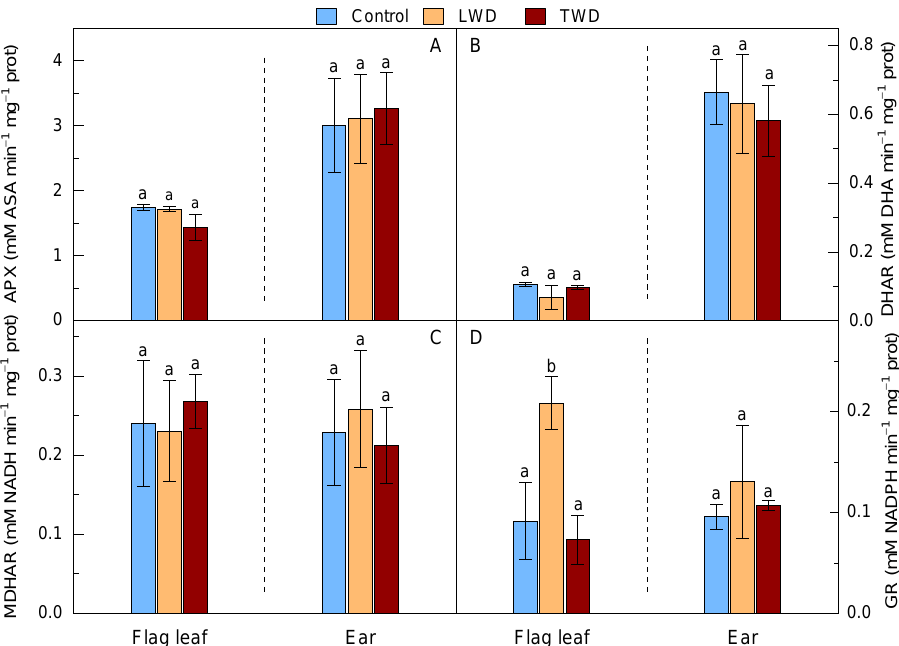
Figure 6. Effect of two water deficit treatments under combined elevated CO 2 and high temperature on ascorbate peroxidase (APX) (Panel A ), dehydroascorbate reductase (DHAR) (Panel B ), monodehydroascorbate reductase (MDHAR) (Panel C ) and glutathione reductase (GR) (Panel D ) activities in flag leaf and ear of potted wheat. Legend is as described in Figure 2. Bars represent mean values ± SD. Different letters above the bars (a and b) indicate statistically significant differences among treatments for each organ after post-hoc test analyses ( p -value ≤ 0.05, n = 4, see Spreadsheet S1, Treatments).